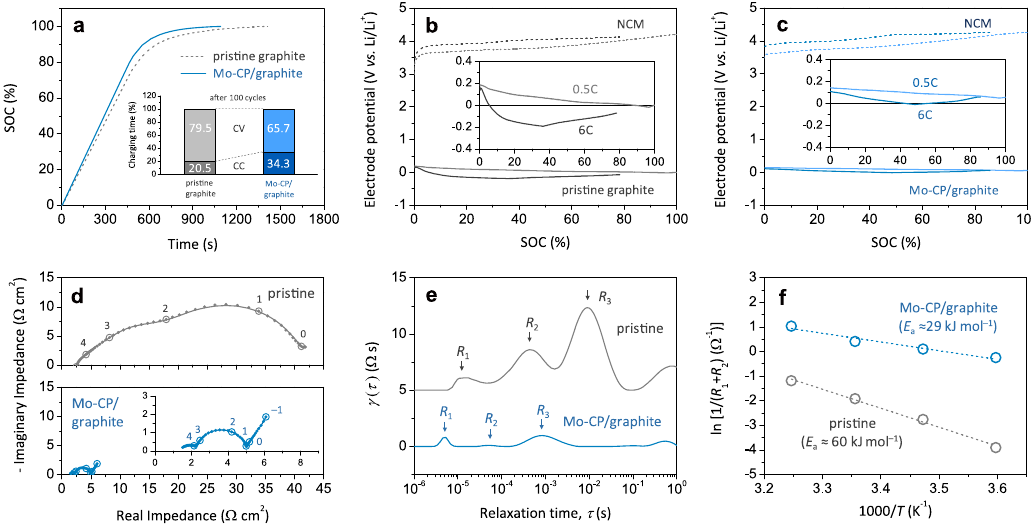
Fig. 4 Fast-charging capability of Mo-CP/graphite. a SOC vs. time pro fi les of full cells with pristine graphite and Mo-CP/graphite anodes. Relative contributions of CC charging and CV charging modes to the total charging time after 100 cycles are presented in ( a ). b , c Voltage pro fi les of electrodes in full cells with pristine graphite ( b ) and Mo-CP/graphite ( c ) anodes. d , e AC-impedance spectra ( d ) and DRT plots ( e ) of half-cells. In the three-electrode half-cell, pristine graphite or Mo-CP/graphite was used as the working electrode, while Li was employed as counter and reference electrodes. Solid lines in ( d ) represent the results of fi tting based on DRT analysis, and numbers above open circles in ( d ) indicate logarithmic frequency values. f E a values for interfacial desolvation/migration reactions ( R 1 + R 2 ) calculated from the temperature dependence of